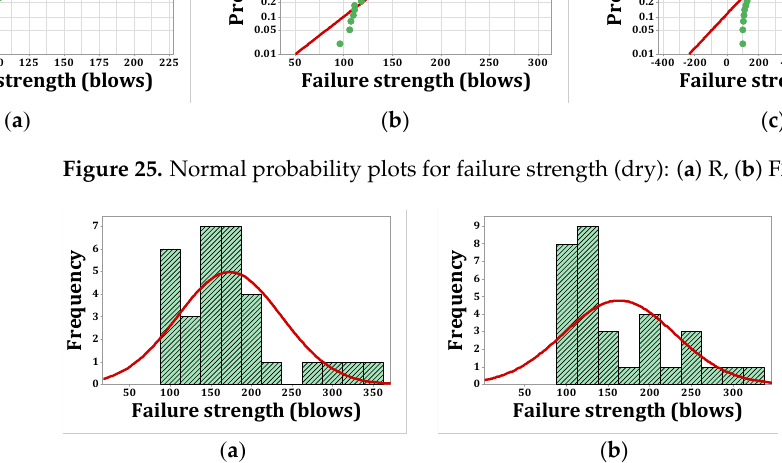
Figure 26. Distribution plots for failure strength (dry): ( a ) F5, ( b ) F2F3.